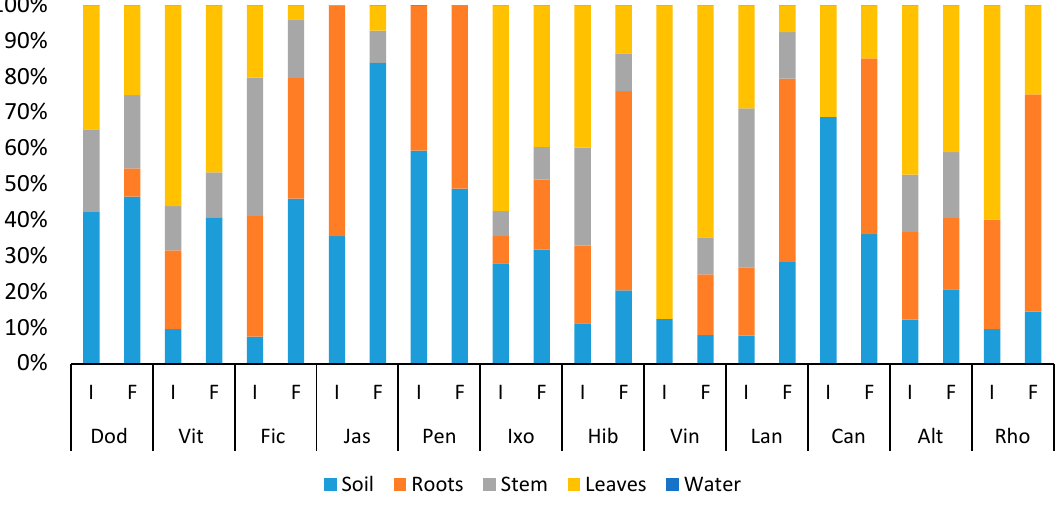
Figure 7. Distribution of Zn in the biofiltration components at the beginning (I, before irrigation with greywater) and at the end (F, after irrigation with greywater) of the experiment.